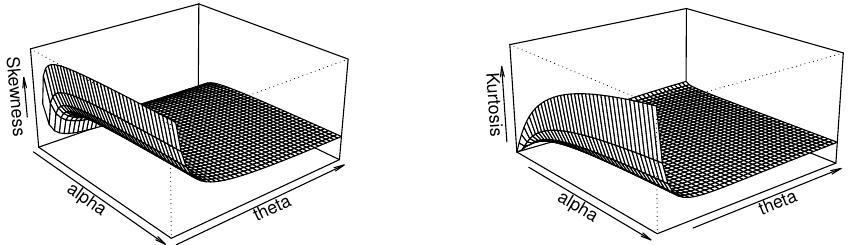
Figure 3. Plots of Bowley’s skewness and Moors’s kurtosis of the ECSP